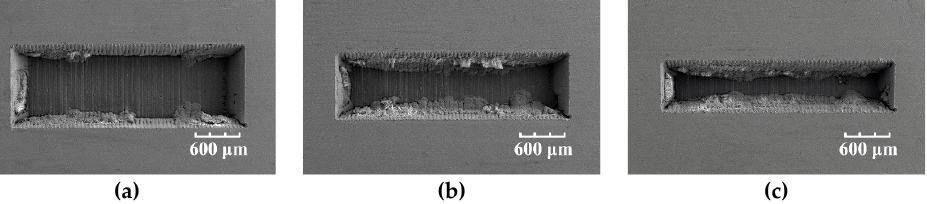
Figure 9. SEM of workpieces of different widths processed by conventional laser processing, shown after ultrasonic cleaning: ( a ) width of 1 mm, ( b ) width of 0.8 mm, ( c ) width of 0.6 mm.